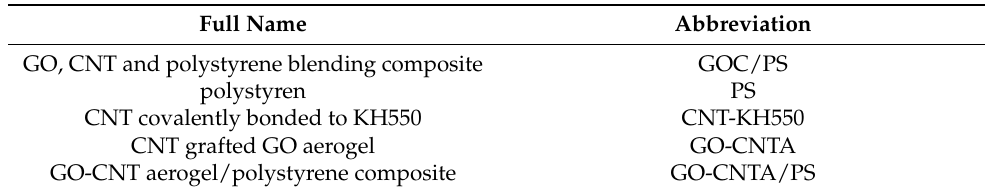
Table 1. Abbreviation of sample.